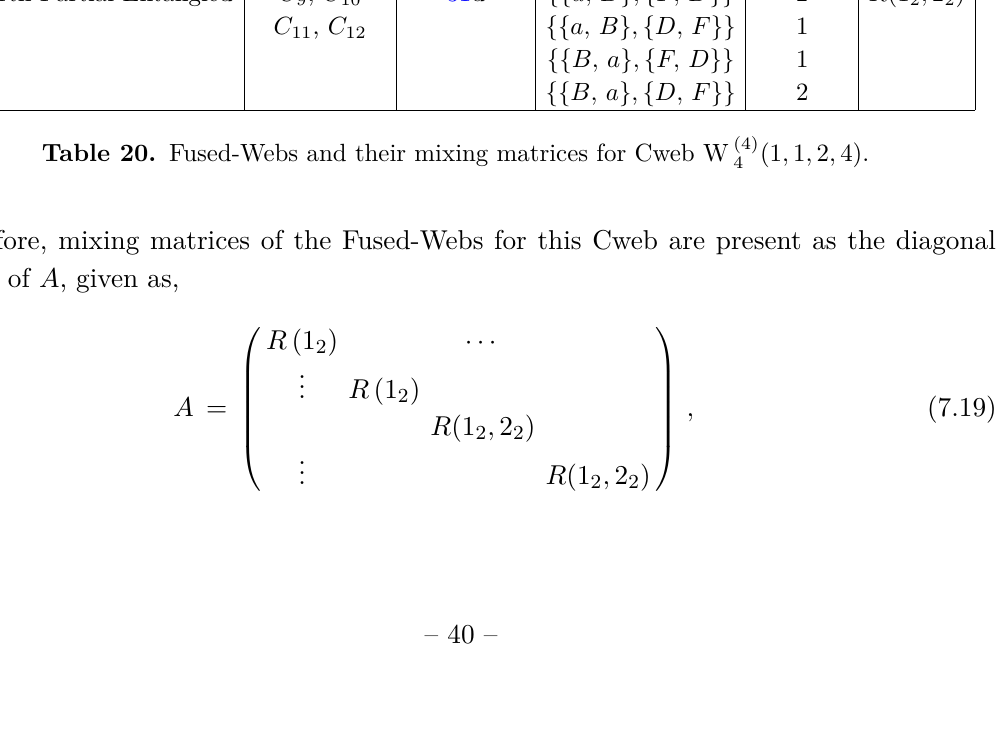
Table 20. Fused-Webs and their mixing matrices for Cweb W (4)